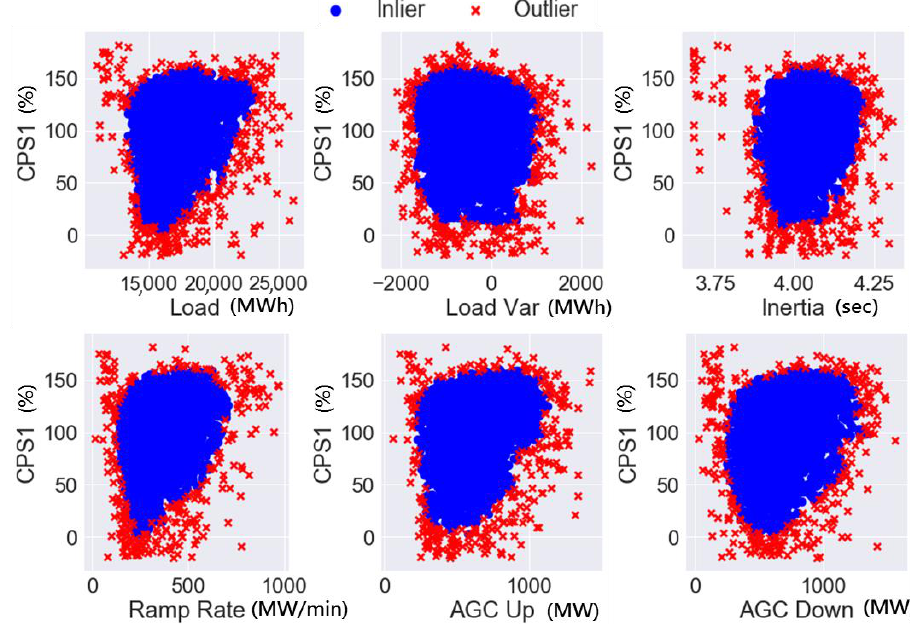
Figure 3. Outlier detection results for six features.